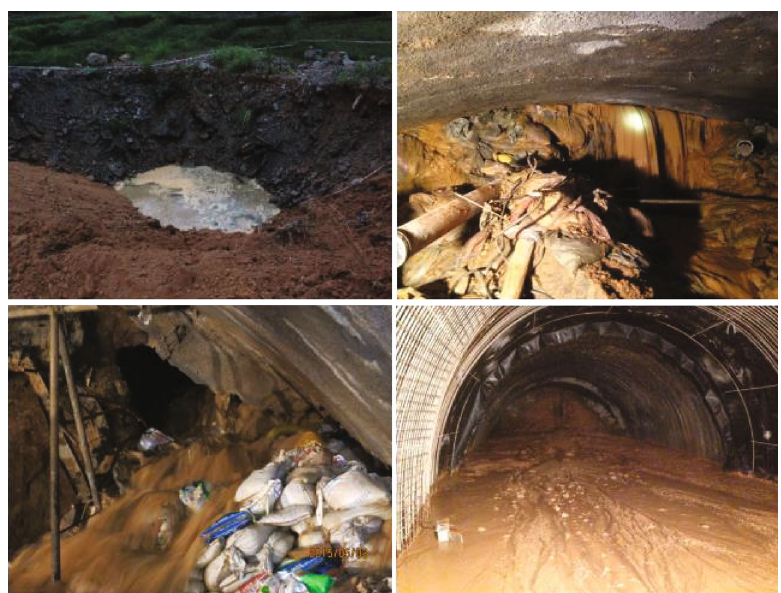
Figure 2: Disaster caused by water and mud inrush of Junchang tunnel.